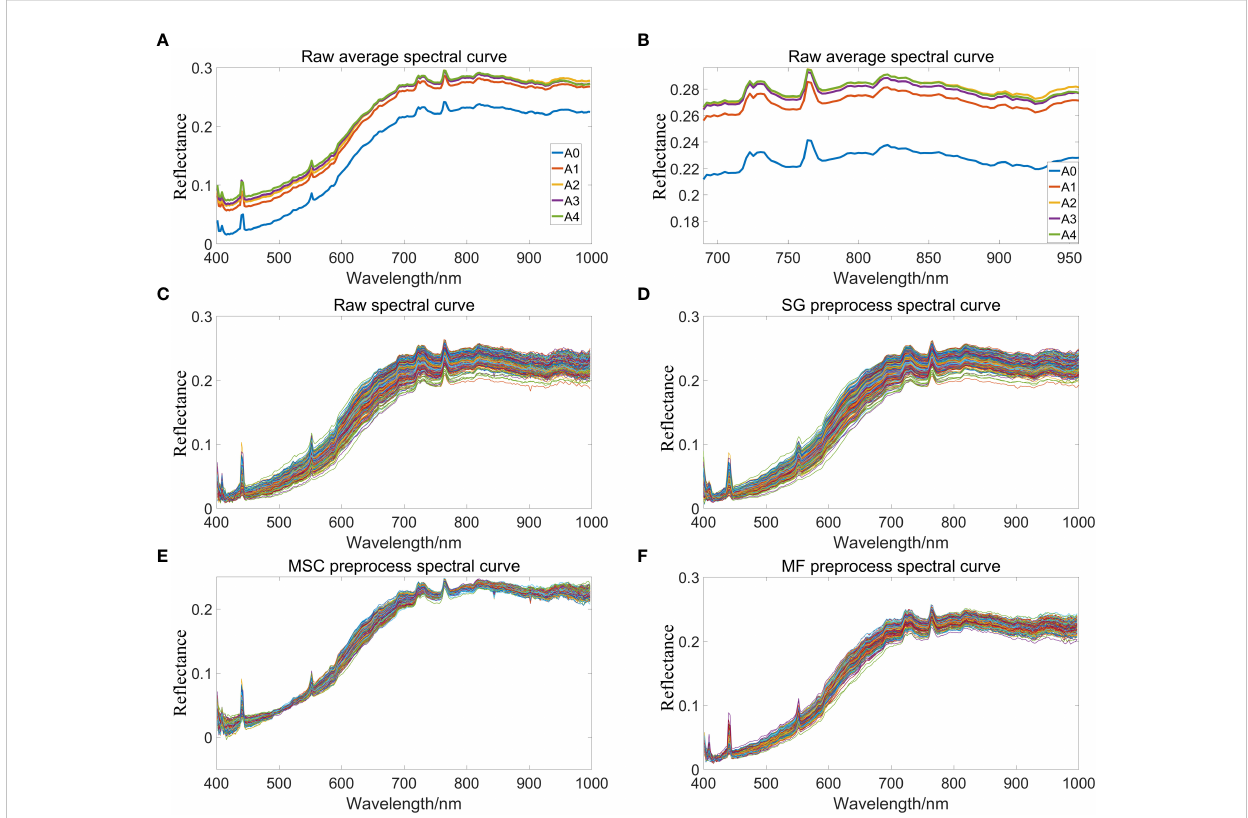
FIGURE 4 Spectral re fl ectance curve of peanuts. (A) Raw average spectral curves of peanut seeds with different aging gradients; (B) Partial enlarged view of spectral re fl ectance curve; (C) Raw spectral curve of peanut; (D) SG preprocess spectral curve of peanut; (E) MSC preprocess spectral curve of peanut; (F) MF preprocess spectral curve of peanut.